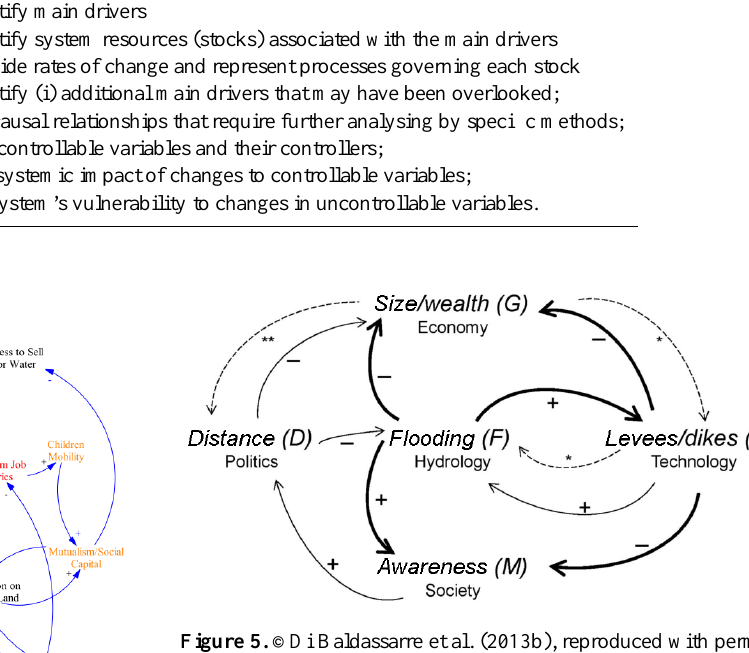
Figure 5. ©Di Baldassarre et al. (2013b), reproduced with permis- sion under the CC Attribution License 3.0. An example of a simple CLD from Di Baldassarre et al.